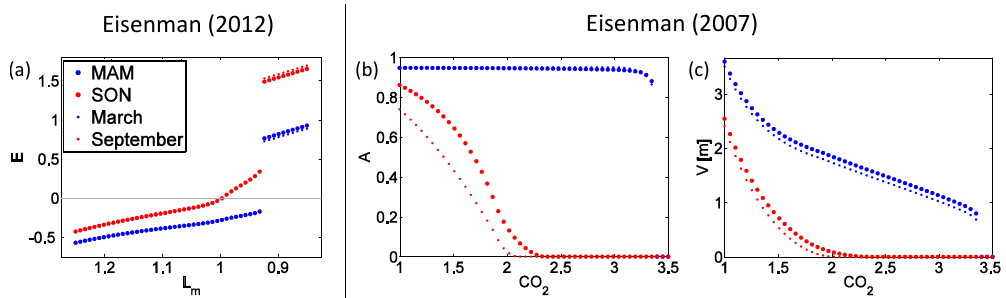
Figure 1. Response of the two column models to warming. (a) Enthalpy versus surface long-wave balance L m in E12. The horizontal line demarcates between positive E (open water) and negative E (ice-covered ocean). (b) Ice-area fraction and (c) ice volume (given as an equivalent thickness) versus CO 2 (given as multiples of the pre-industrial value) in E07. Each dot represents a time mean over the season indicated in the legend of subfigure (a)